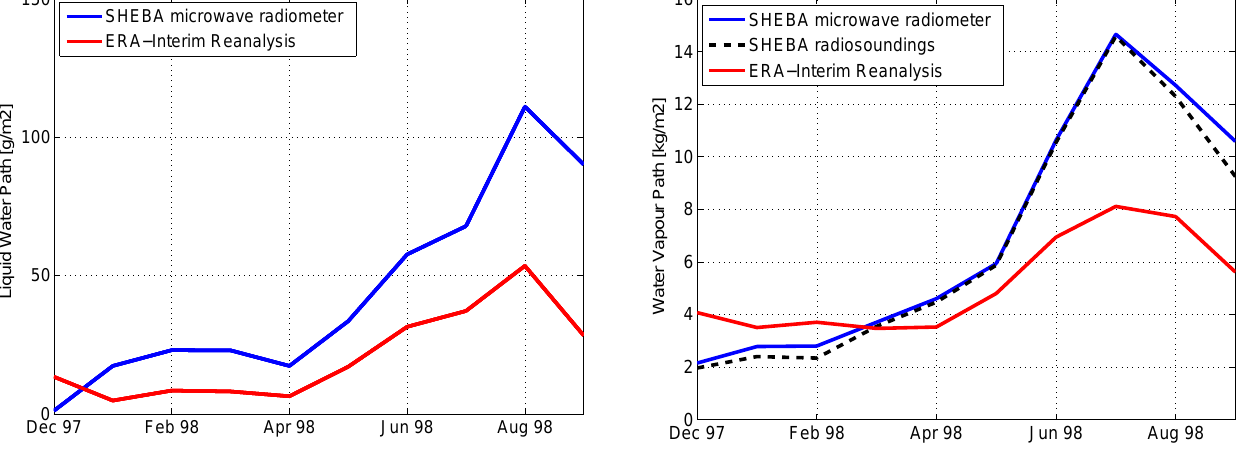
Fig. 7. Comparison of observed and ERA-Interim water vapor path with observations from a dual-channel microwave radiometer and integrated from radiosoundings during the SHEBA